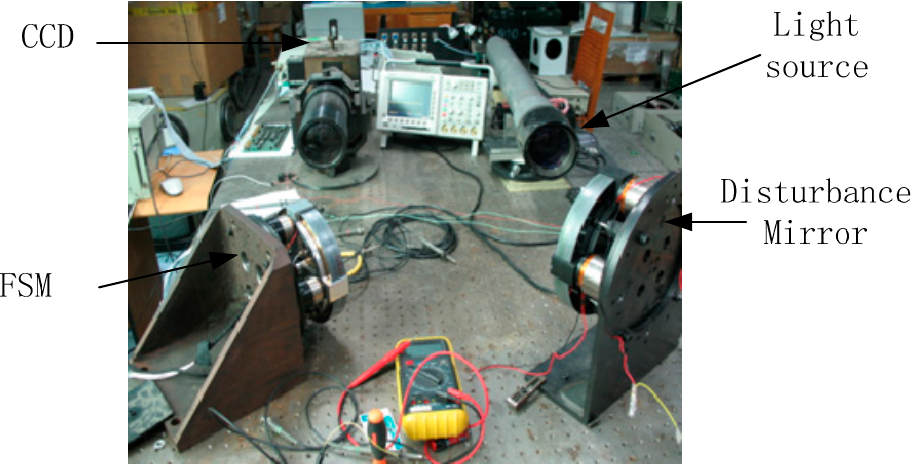
Figure 5. Experimental setup of the CCD control system.